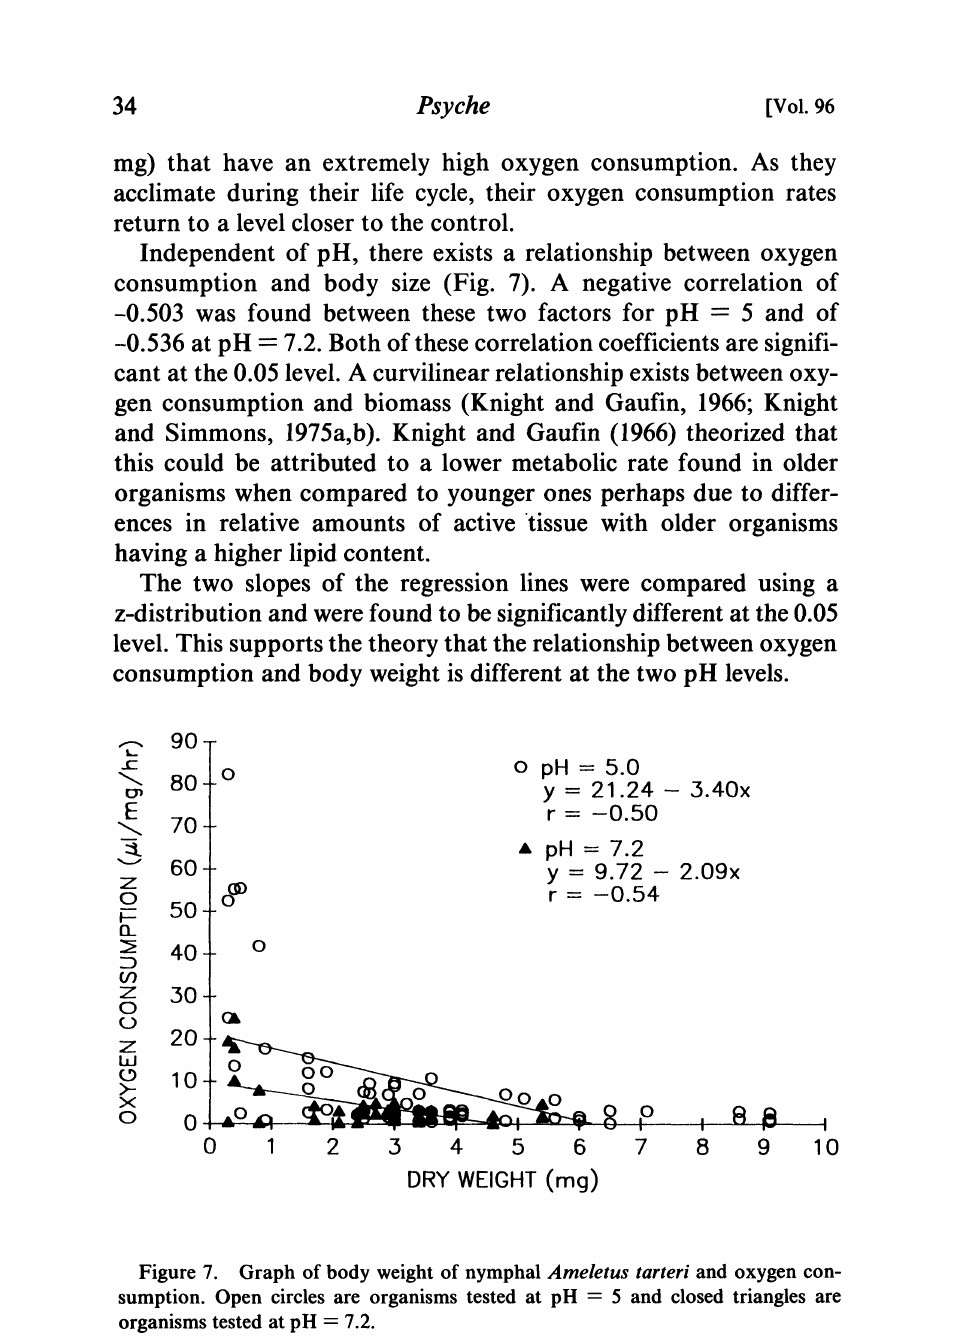
Figure 7. Graph of body weight of nymphal Ameletus tarteri and oxygen con- sumption. Open circles are organisms tested at pH 5 and closed triangles are organisms tested at pH